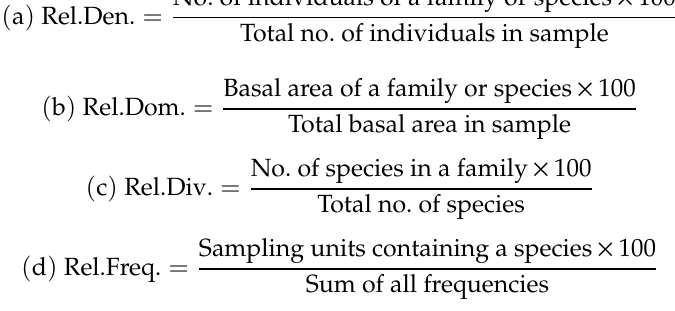
s1, Table S1: Family Importance Value, Table S2: Species Importance Value Index, Table S3: Bray-Curtis Dissimilarity